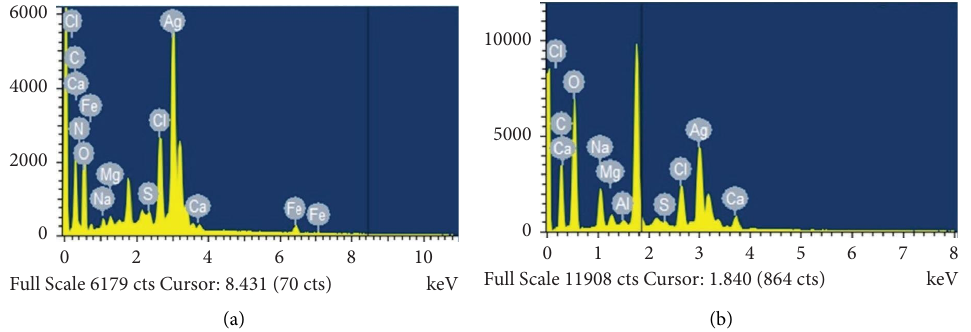
Figure 6: EDX results showing presence of silver element in (a) SeWt-AgNPs and (b)